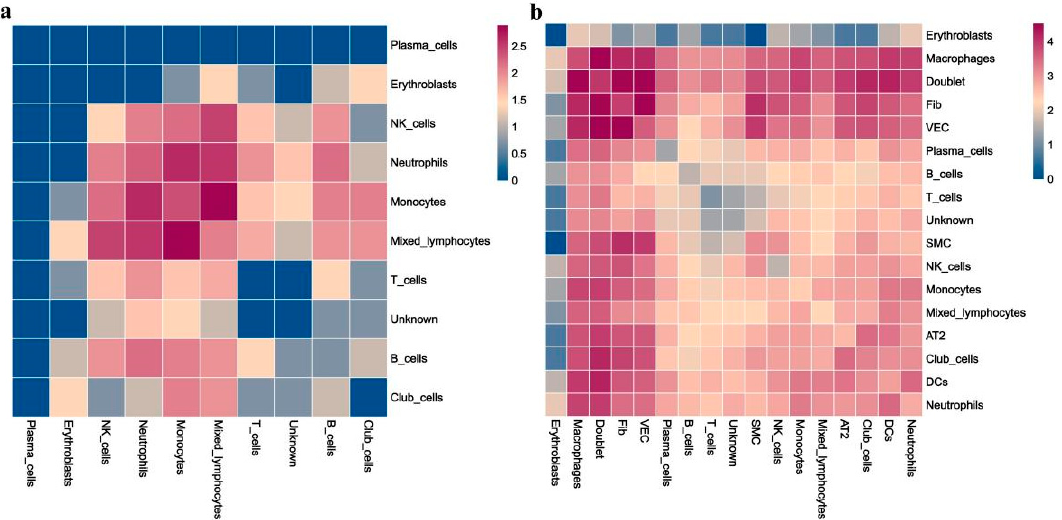
Figure 9. Heatmaps of identified potential cell–cell crosstalk in control (CN) ( a ) and RP groups ( b ).